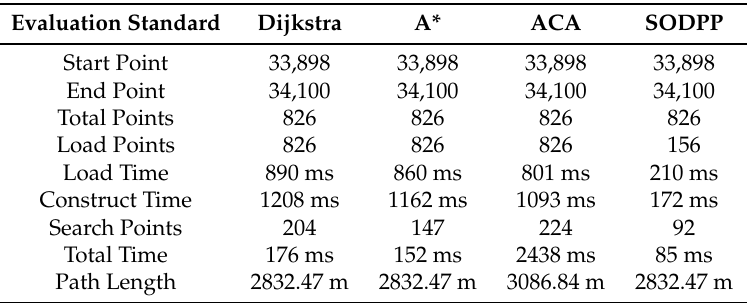
Table 3. Comparison of results for Experiment 2.